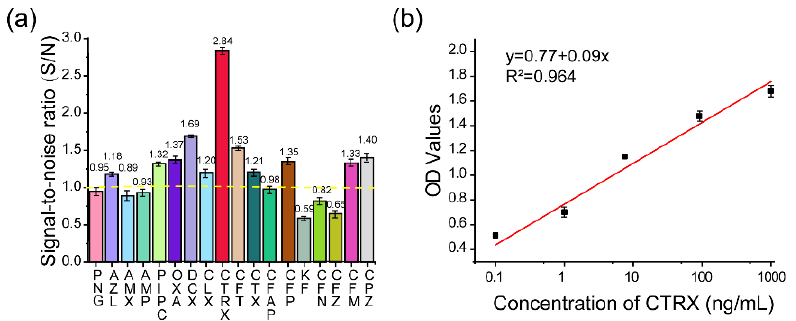
Figure 3. ( a ) The S/N of the sandwich immunoassay for detection of 18 β -lactams ( n = 3). S/N > 1 indicates positive detection by the sandwich immunoassay, while S/N ≤ 1 indicates negative detection. ( b ) Standard curve of the sandwich immunoassay for CTRX detection ( n = 3).